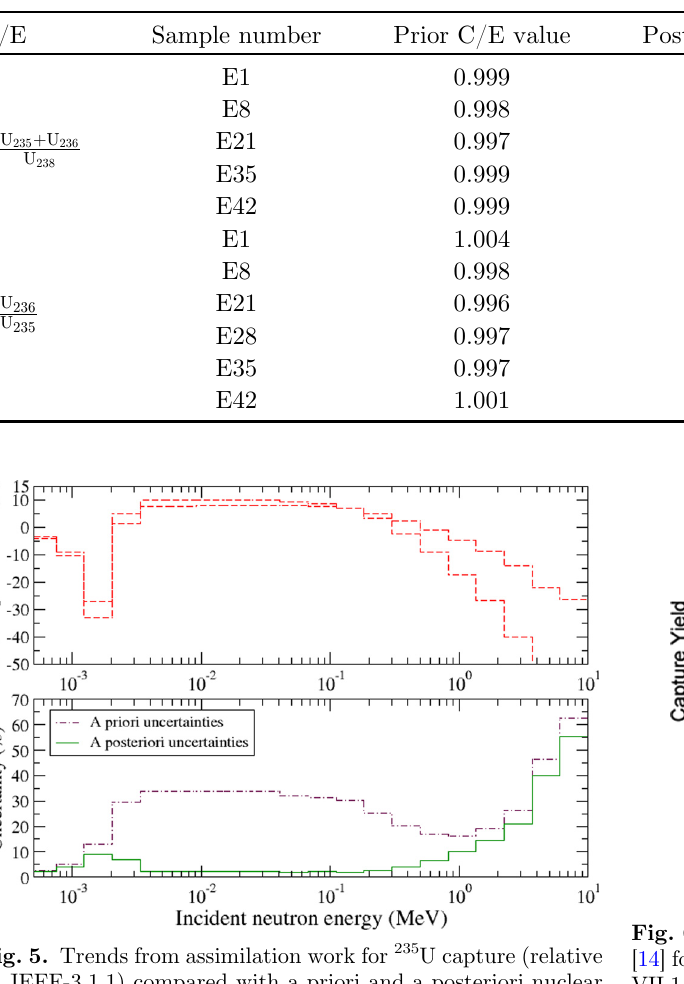
Table 4. Prior and posterior C/E values for PROFIL-2A variation of concentrations ratios and associated uncertainties.